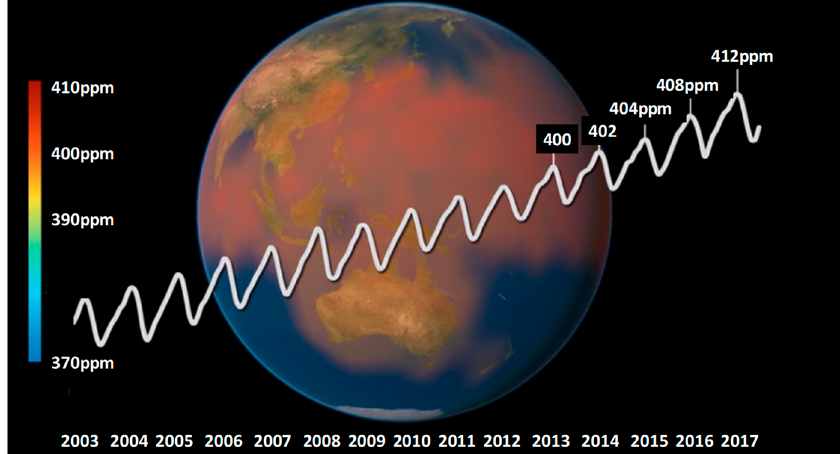
Figure 4. World carbon cycle: concentrations of carbon dioxide in the atmosphere [3].